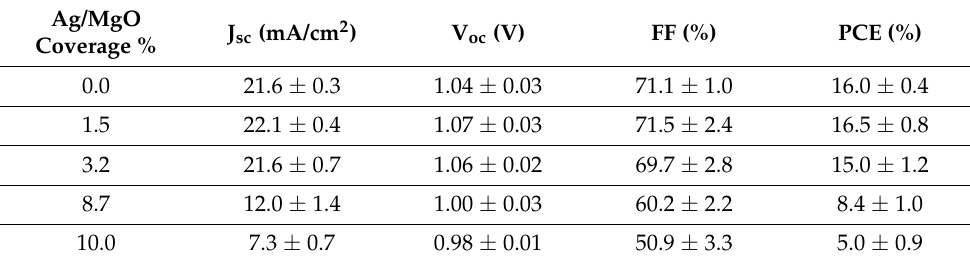
Table 1. Main parameters, with their standard deviations, for devices ranging between 0.0% and 10.0% of surface coverage in Ag/MgO NPs atop an m-TiO 2 layer. Ag/MgO Coverage %